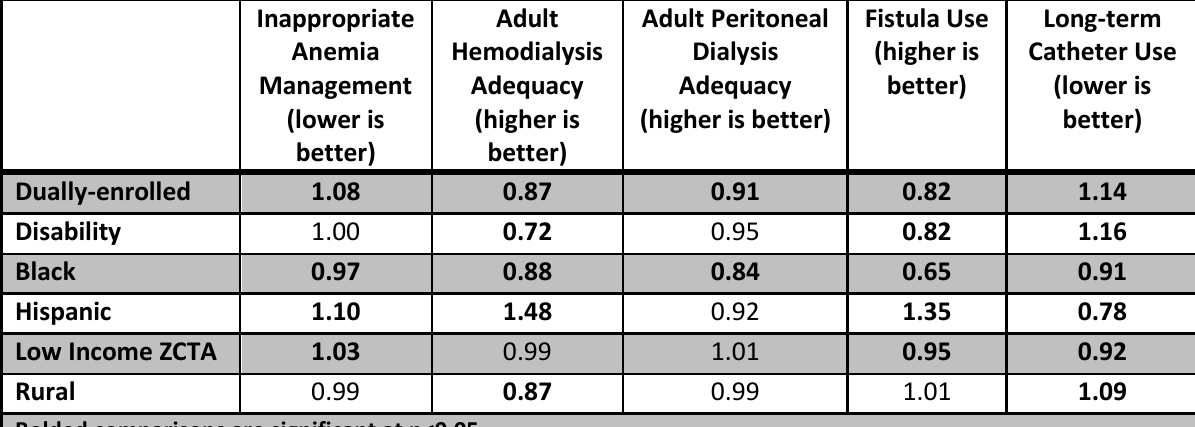
Table 11.3: PY 2015 ESRD QIP Quality Measures and Social Risk Factors, Total Odds Ratios